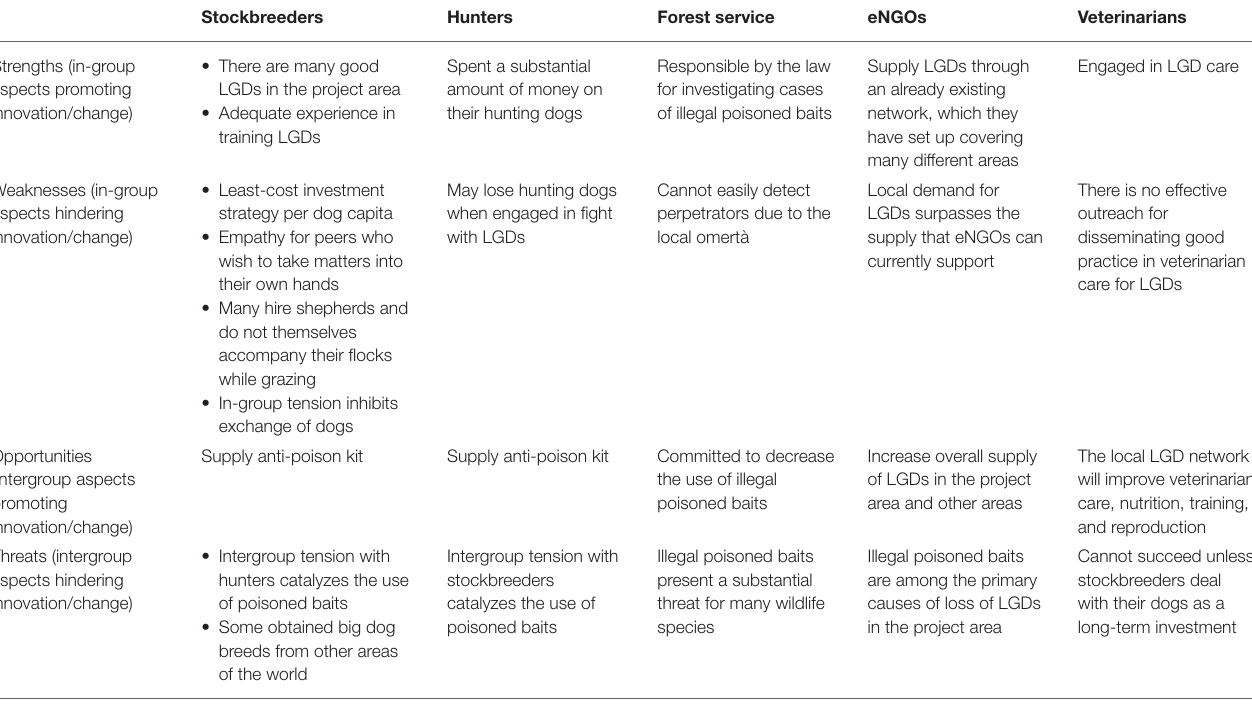
TABLE 7 | SWOT analysis template for LGDs.